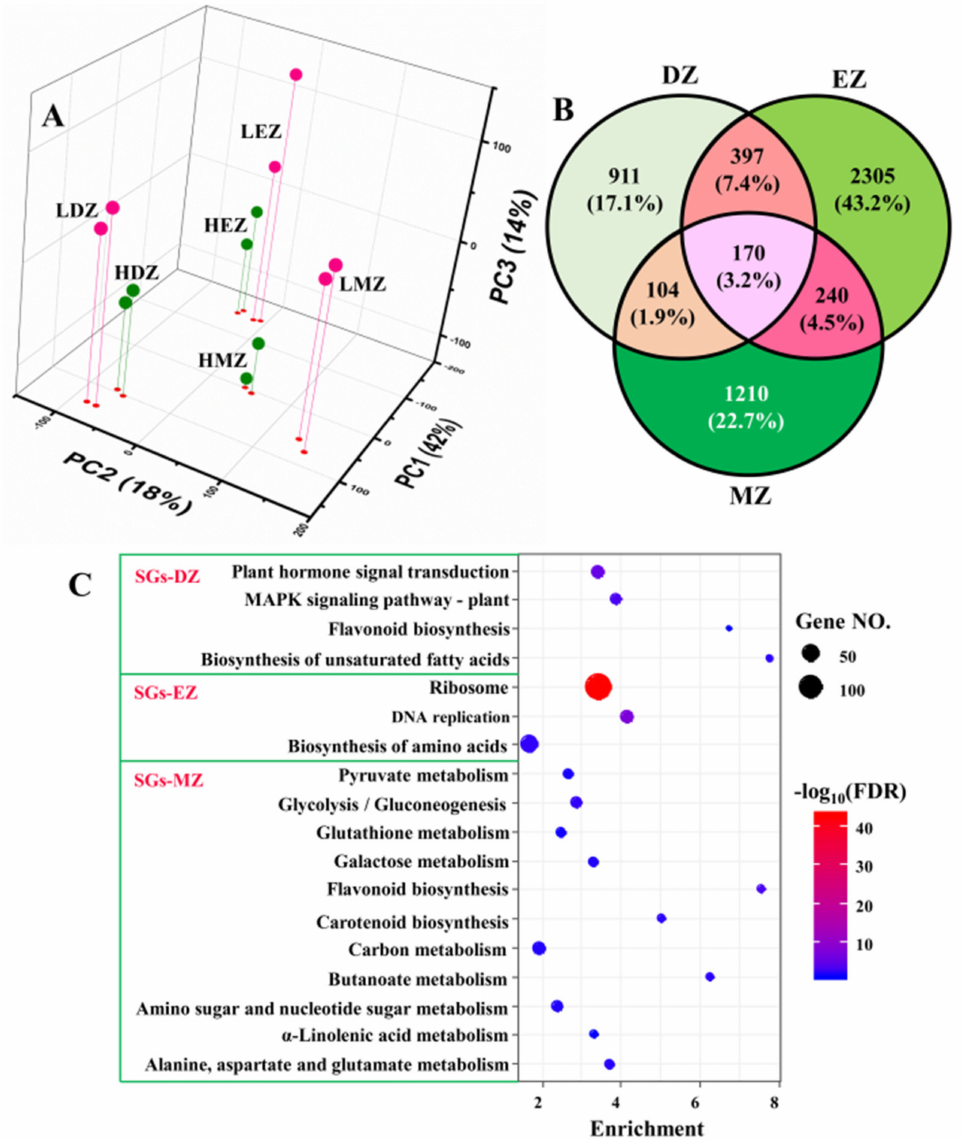
Figure 1. The 3D scatterplot represents the first three principal components (PCs) of the gene expres- sion profiles in different regions of maize leaves under low nitrogen (LN) and high nitrogen (HN) conditions ( A ). LDZ—division zone under LN; HDZ—division zone under HN; LEZ—elongation zone under LN; HEZ—elongation zone under HN; LMZ—mature zone under LN; HMZ—mature zone under HN. The Venn diagram shows the stage-specific genes (SGs) and common genes in the three different comparisons ( B ), namely, LDZ vs. HDZ (DZ for short), LEZ vs. HEZ (EZ), and LMZ vs. HMZ (MZ). In panel ( C ), the KEGG analysis of the stage-specific genes (SGs) in division zone (SGs–DZ), elongation zone (SGs–EZ), and mature zone (SGs–MZ) are